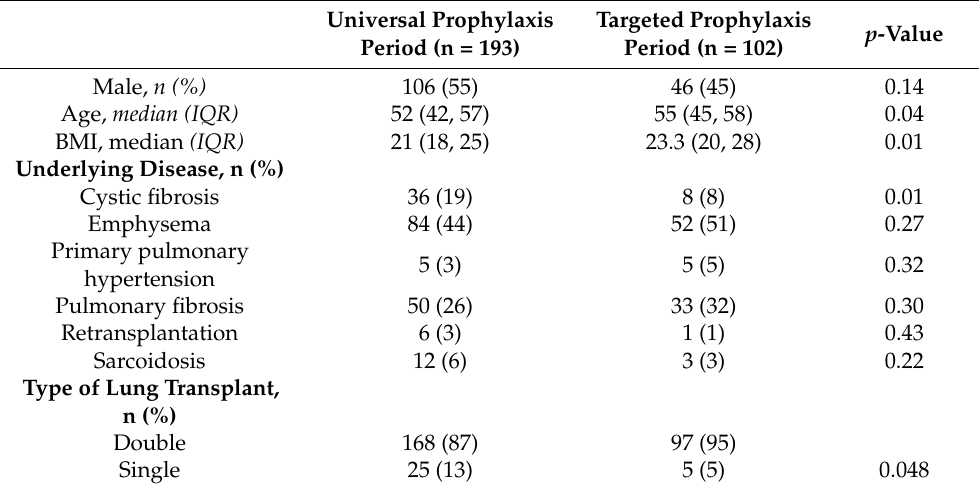
Table 1. Patient characteristics at time of lung transplantation in the universal- and targeted antifungal prophylaxis